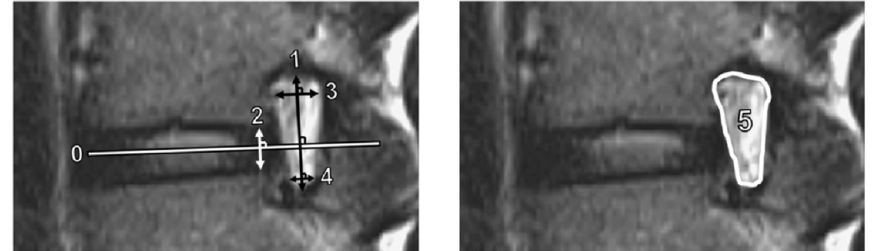
Figure 2. Measurements of magnetic resonance imaging parameters. Line 1 is the foraminal height; Line 2, disc height; Line 3, superior foraminal width; Line 4, inferior foraminal width; and Area 5, foraminal area. The anterior–posterior axis of the intervertebral disc (Line 0) was identified first. Lines 1 and 2 were constructed perpendicular to Line 0. Lines 3 and 4 were constructed parallel to Line